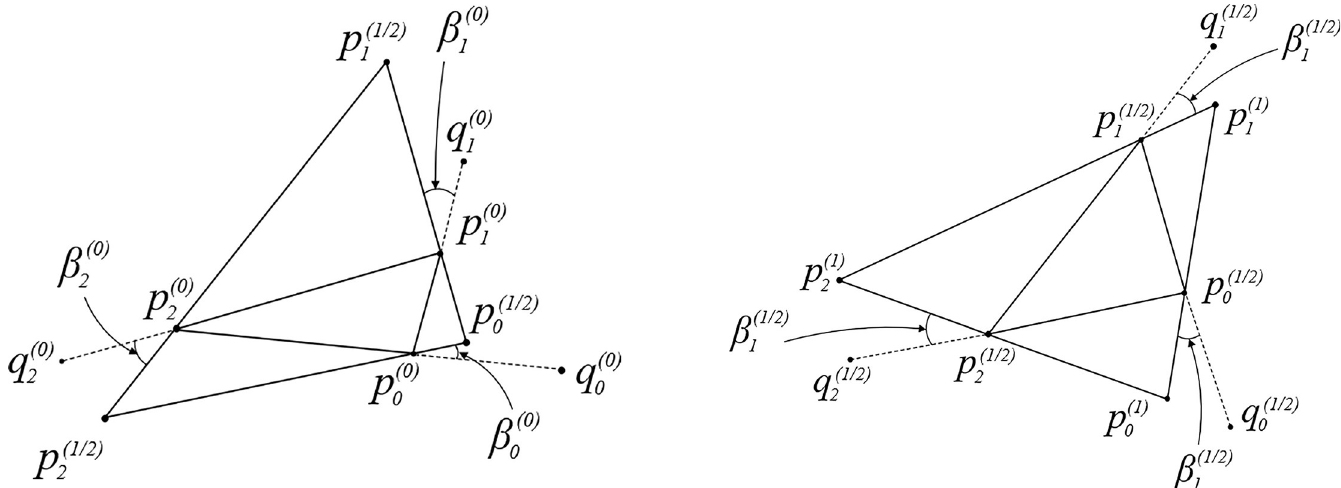
Fig 1. Substages of the first stage for EAS method. a) the first substage in counterclockwise direction; b) the second substage in clockwise direction.